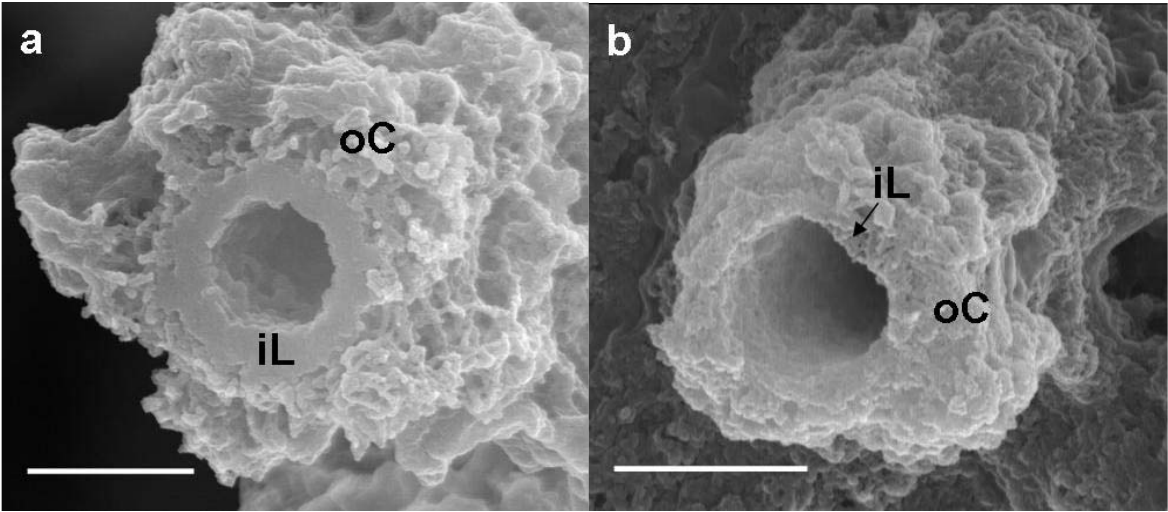
Figure 2. SEM images of a sheath of medium cultures (a) or groundwater (b) at day 14. ( a ) A sheath with a homogeneous-looking thick inner layer (iL) enclosed with an outer coat (oC) composed of heavily intermingled and coagulated thick fibrils; ( b ) A sheath with a heterogeneous-looking thin inner layer (iL) enclosed with an outer coat (oC) of intermingled and coagulated thick fibrils. Scale bar = 1 μ